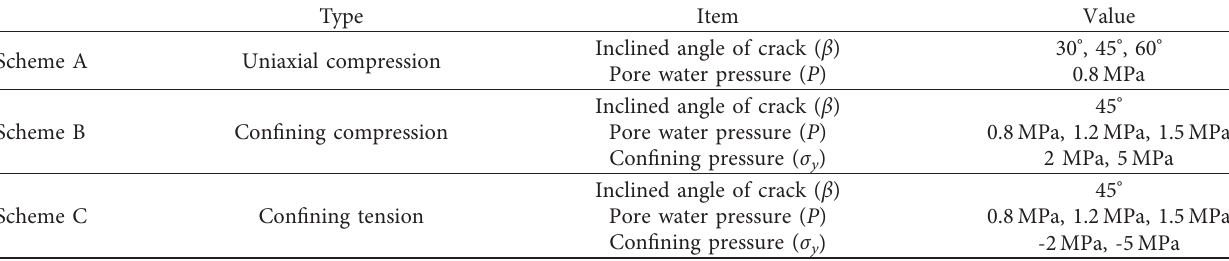
Table 1: The schemes of numerical simulations.